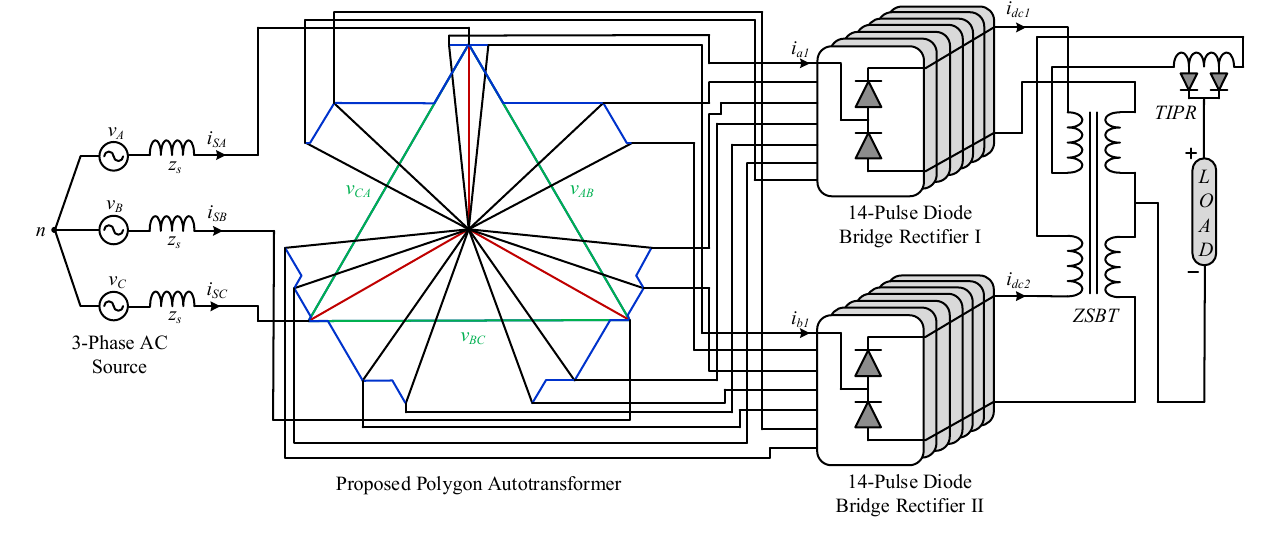
Figure 1. The configuration of the 56-PR.